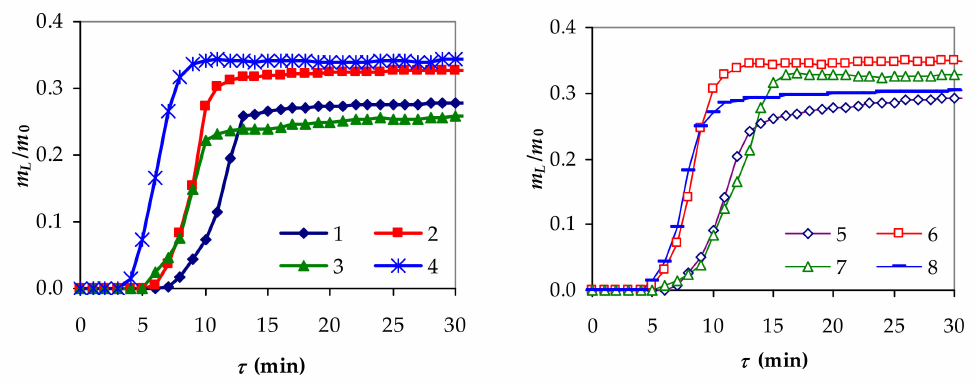
Figure 4. Specific mass of pyrolysis liquid (bio-oil) vs.